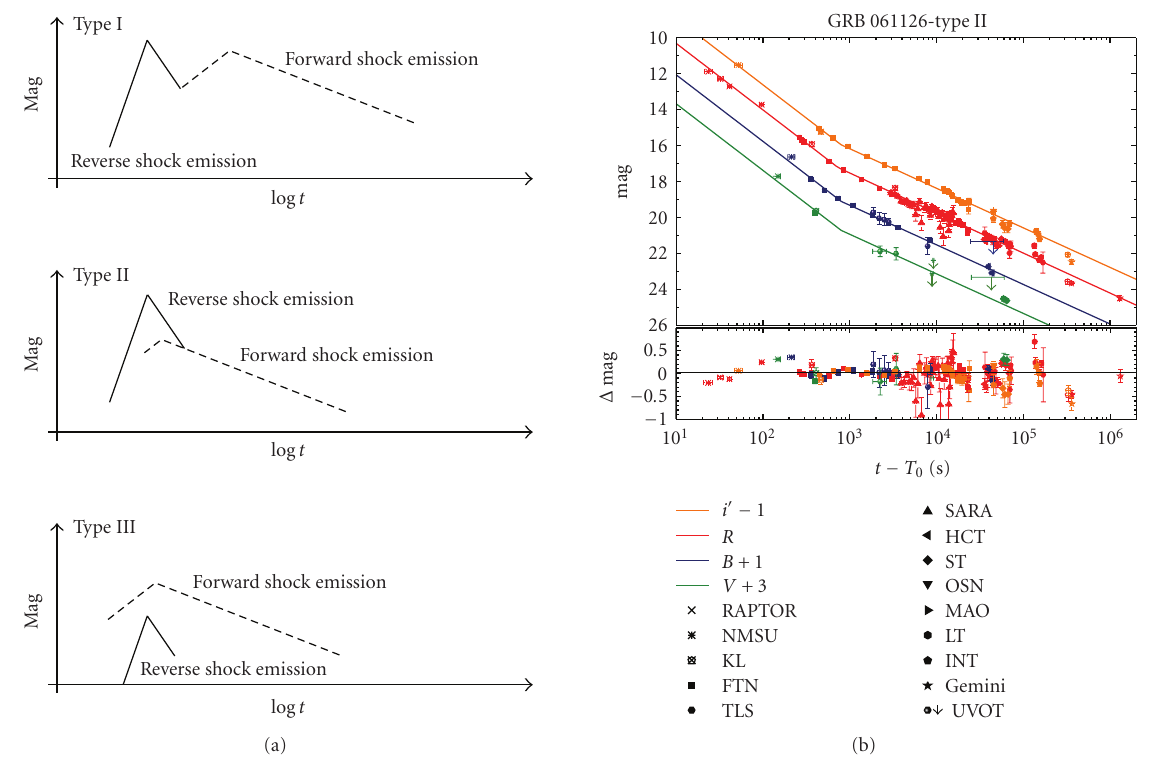
Figure 6: (a) Light-curves with di ff erent reverse-forward shock contributions. Magnetic energy density determines the relative contributions [61]. (b) Optical light curves of GRB 061126 showing the steep-to-shallow temporal break characteristic of a Type II reverse-forward shock observed after the reverse-shock peak [62].